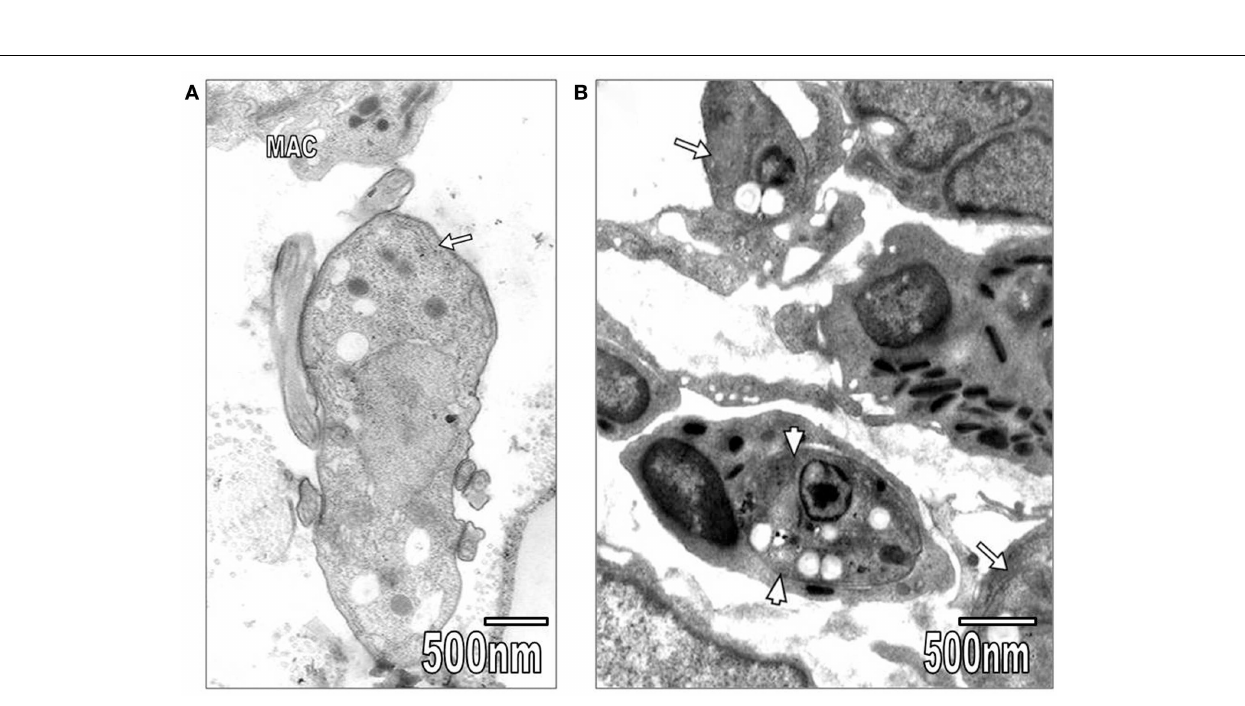
FIGURE 4 | (A) Section from proximal convolute tubule of a mouse parasitized by T. evansi is shown. Observe portions of interdigitations (arrowheads), swelling of RER cisternae, and mitochondrial cristae (open circle). In the